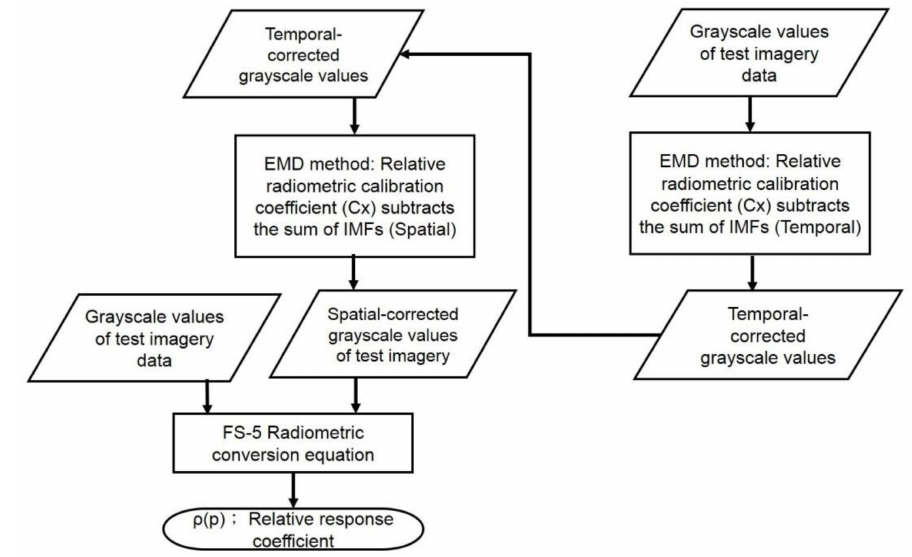
Figure 10. The flowchart of relative radiometric calibration both in temporal and spatial variations. The step of the relative radiometric calibration in the spatial variation is based on the grayscale values calibrated in the temporal variation.